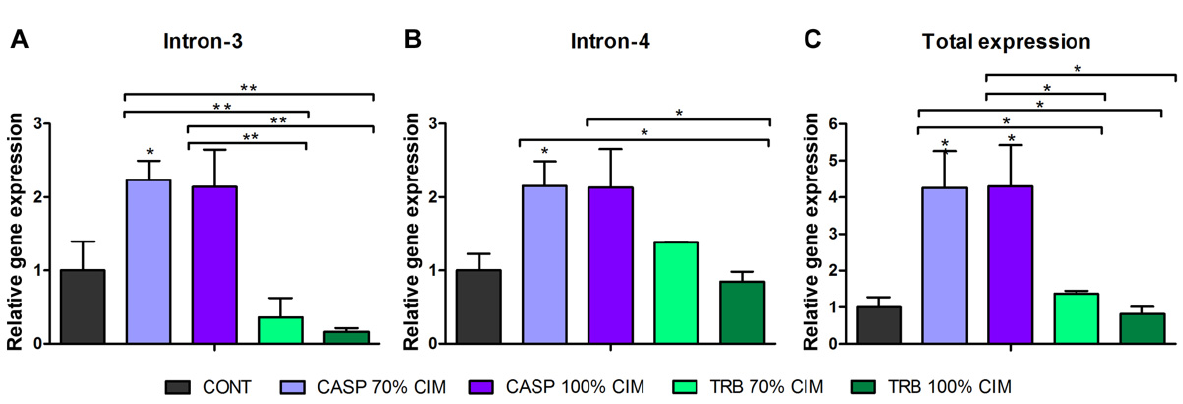
Figure 5. RT-qPCR analysis of the expression levels of different isoforms of the T. rubrum gene TERG_04309 after 1 h of biofilm exposure to antifungal agents. ( A ) Expression levels of isoform with intron-3 retention. ( B ) Expression levels of the isoform with intron-4 retention. ( C ) Total expression levels of the TERG_04309 gene. Statistical analysis was performed using the t -test method. Asterisks refer to * p < 0.05, and ** p < 0.01. As a reference for modulation, the condition of paired controls of 1 h and 12 h was used. The control sample (CONT); caspofungin (CASP), and terbinafine (TRB).